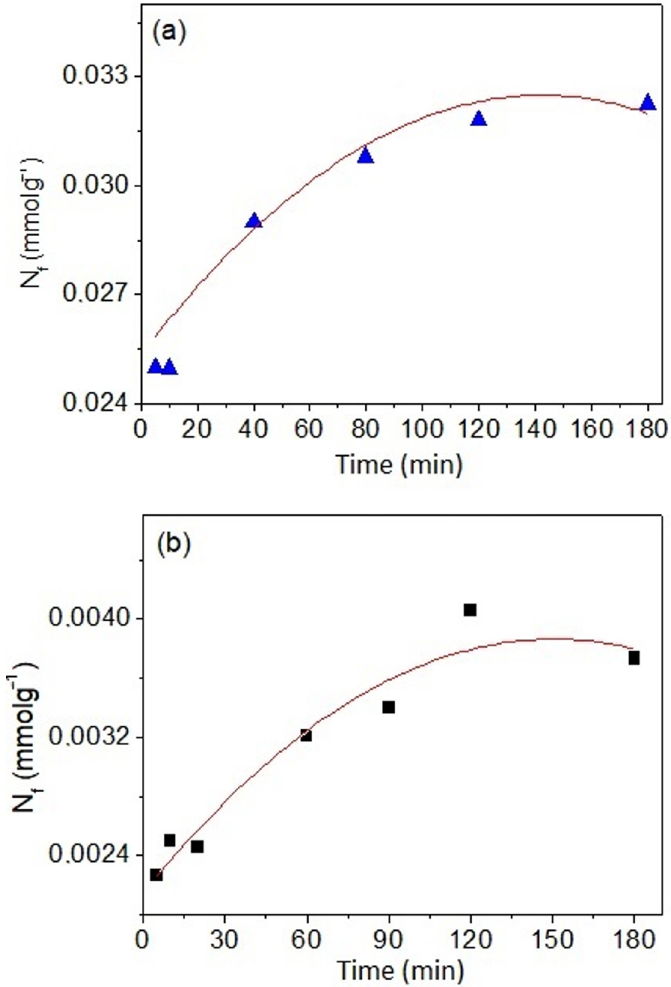
Figure 8. Adsorption isotherms for Cu(II) ( a ) and Cd(II) ( b ). Mass of adsorbent = 20.0 mg; solution volume = 1.80 mL.